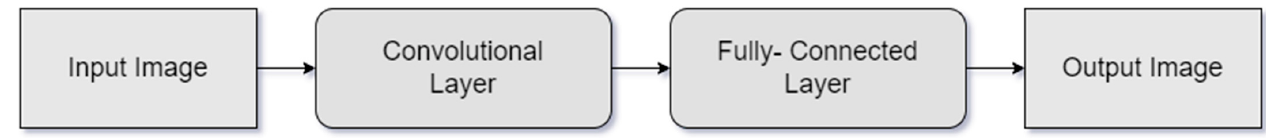
Figure 3. A block diagram of convolutional neural network architecture.